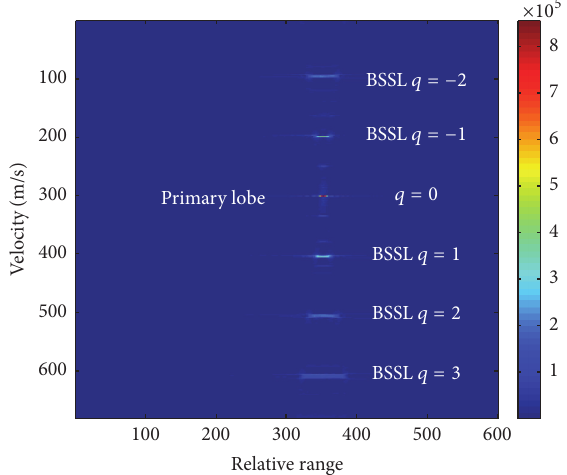
Figure 3: Range and velocity slice of GRFT.